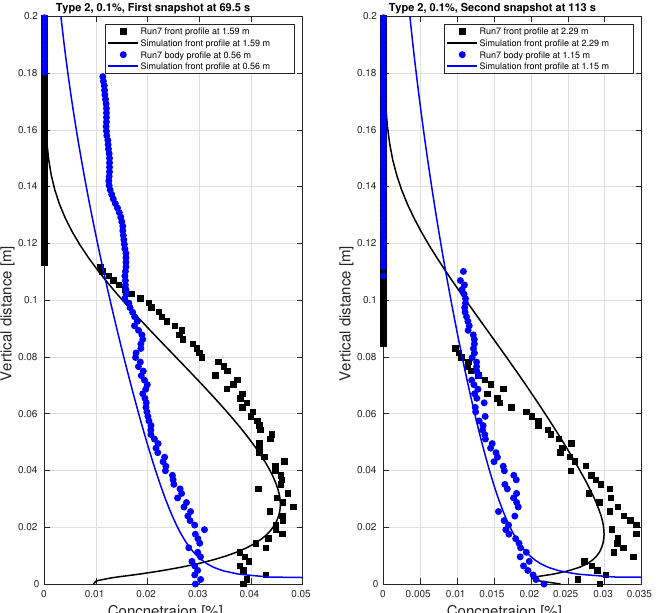
Figure 15. Validation case for run7. Vertical concentration profiles are shown for the front and the body of the current. The first snapshot is taken when the front of the current has almost reached the middle of the